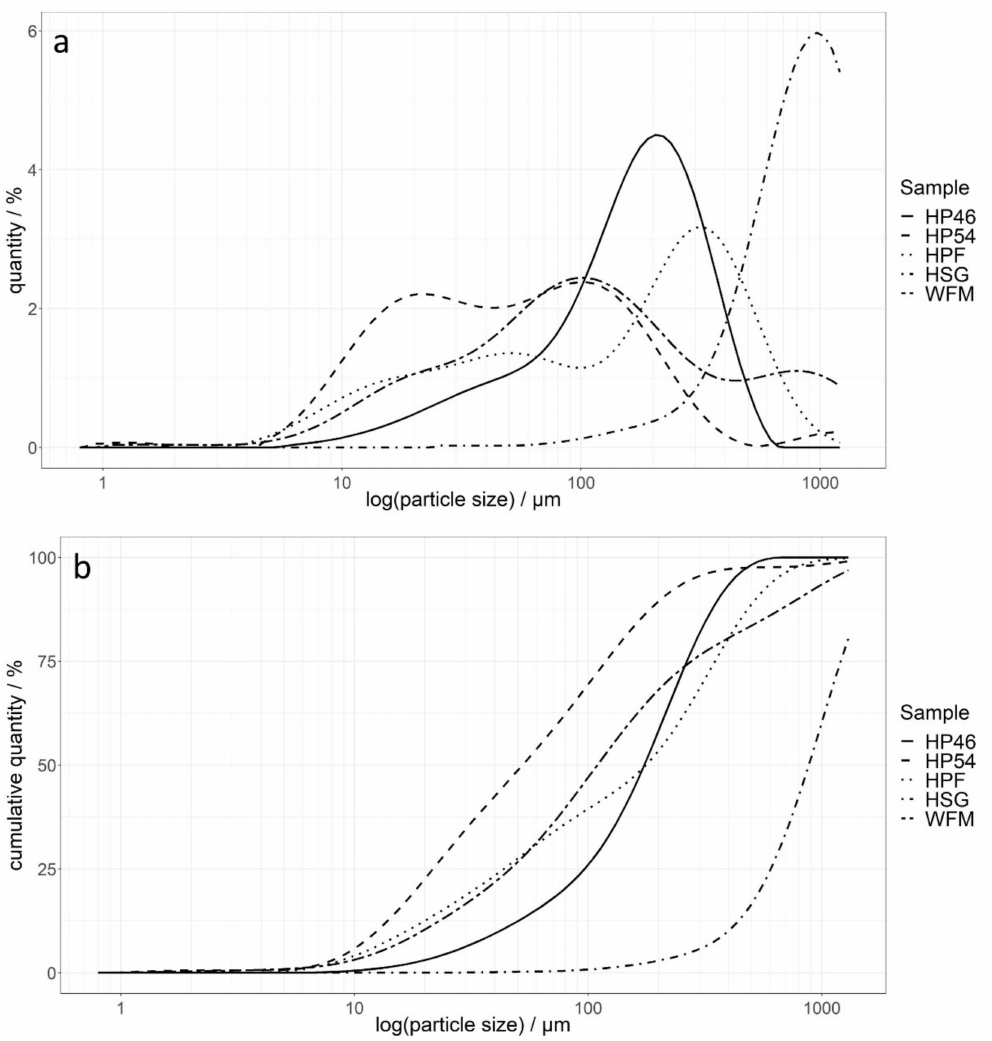
Figure 1. Sample size distribution ( a ) and cumulative sample size distribution ( b ) of all raw materials at 1 bar with 90% feed rate. HSG—hemp seed grit; HPF—hemp press cake flour; HP46—hemp press cake flour protein (46%); HP54—hemp press cake flour protein (54%); WFM—half-and-half mixture of wheat and whole wheat